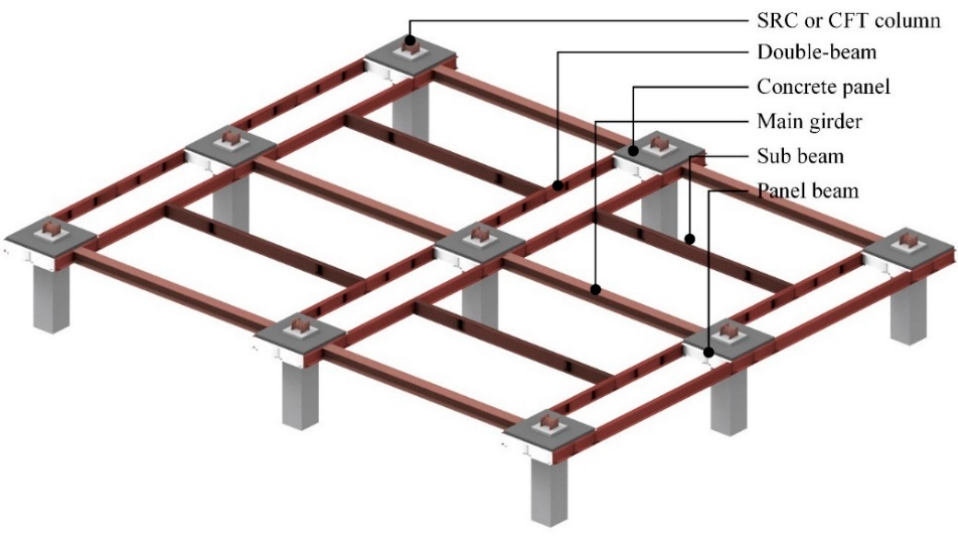
Figure 1. Structural configurations of steel double-beam floor system with the concrete